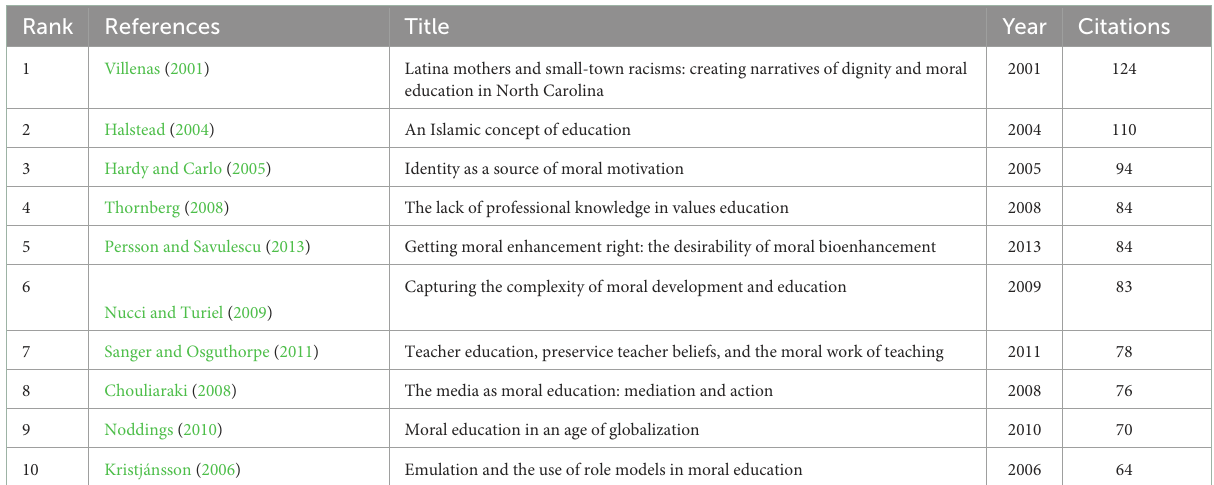
TABLE 6 Most cited articles between 2000 and 2022.